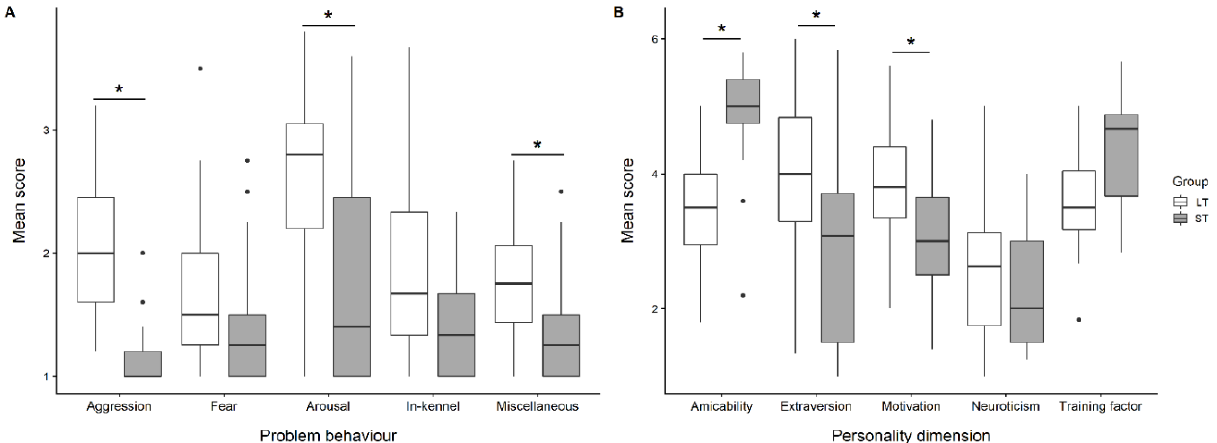
Figure 1. Comparison of LT and ST dogs’ problem behaviour and personality. ( A )—Problem behaviour: Scores were 1 (never), 2 (occasionally), 3 (sometimes), and 4 (frequently). For each dog, a mean score was calculated by summing up the scores per category and dividing them by the number of behaviours; ( B )—Personality assessment: Scores ranged from 1 (really does not describe the dog) to 6 (really describes the dog). The white boxes represent the long-term dogs, the grey boxes represent the short-term dogs. Results considered as statistically significant after correction for multiple testing are indicated with *. Table 4. Analysis of the single problem behaviour items. Scores on a four-point scale were 1 = never, 2 = occasionally, 3 = sometimes, 4 = frequently. Analyses of the single behaviour items were not corrected for multiple testing to identify outstanding behaviours that differ between LT and ST dogs. Significant results are in bold and trends are in italics. The “Problem for adoption” column shows the percentage of behaviours caretakers judged as a problem for adoption. N = 24. Behaviour Group Mean SD Min Max p Problem for Adoption in % p Aggression towards dog